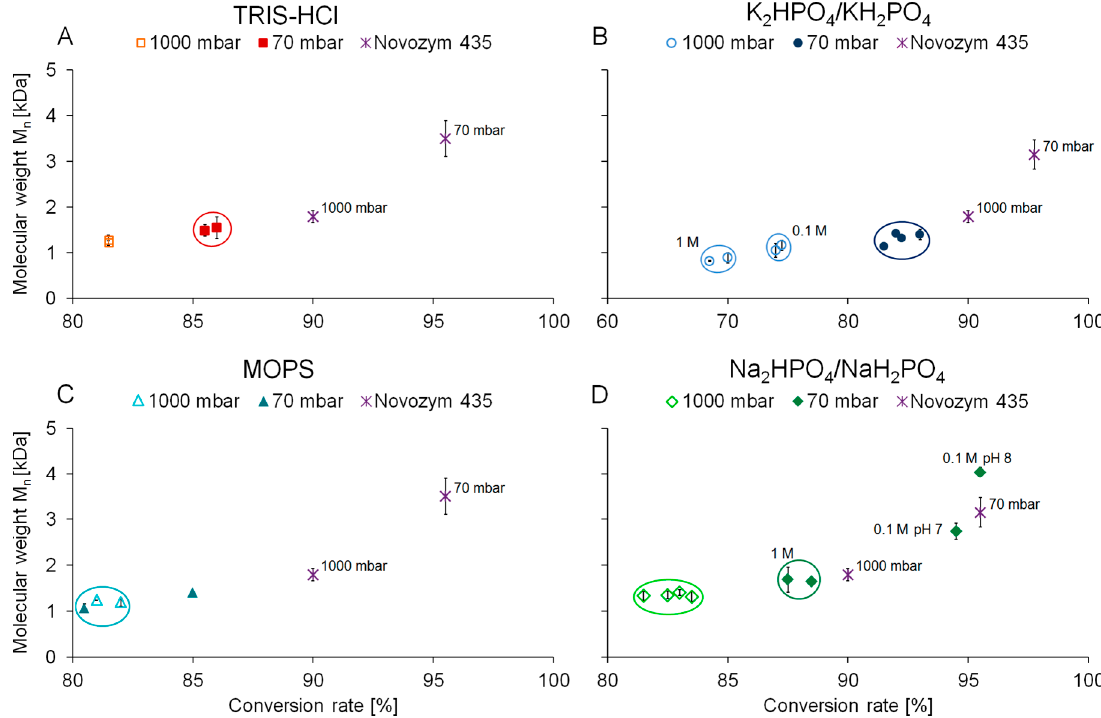
Figure 3. Molecular weights M n [kDa] and conversion rates [%] of polyesters synthetized with CaLB immobilized onto polypropylene beads in 1/0.1 M K 2 HPO 4 \KH 2 PO 4 and Na 2 HPO 4 \NaH 2 PO 4 pH 7 and 8; 1/0.1 M Tris-HCl and MOPS pH 7. The polymerization reactions were performed at 1000 and 70 mbar respectively, and compared to the product of the same reactions catalyzed by Novozym 435. Resulting clusters are highlighted with circles. All reactions were performed in duplicates.